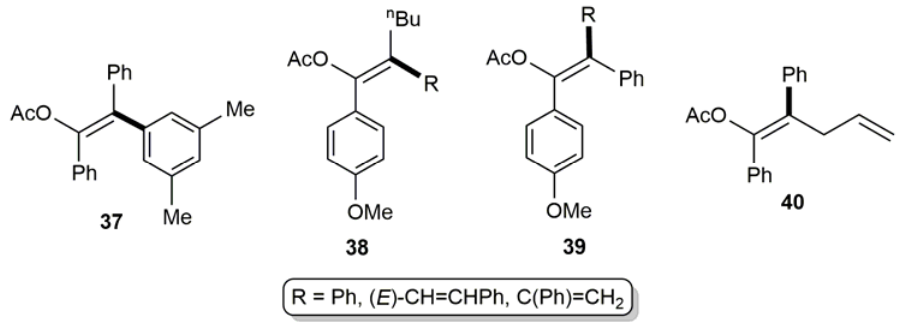
Figure 5. Structure of the tetrasubstituted olefins 37 – 40 .